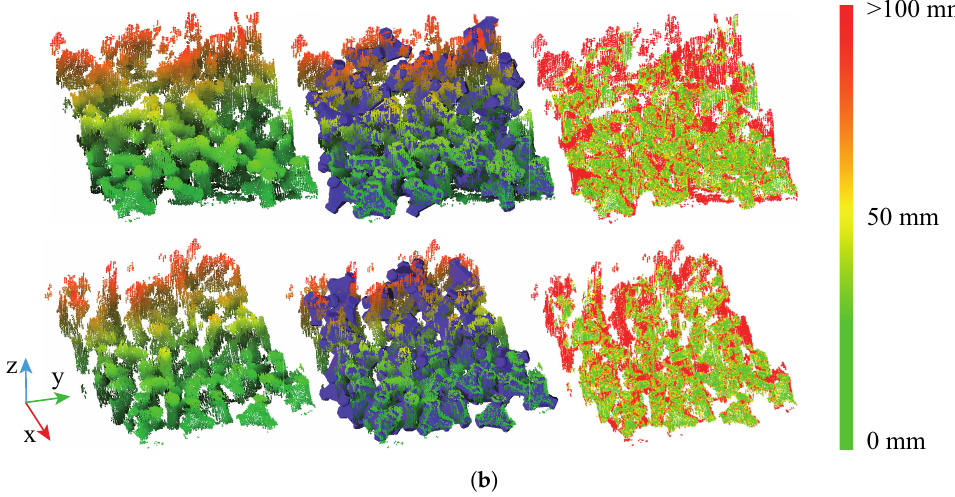
Figure 16. Visualization of pose estimation on UAV data ( a ) and MBES data ( b ) of Sawara port. The first column is the measured point cloud. The block models are transformed to the scene space using pose results and displayed in the middle column. The last column is a visualization of the average fitting error of the pose estimates, where the red points indicate that its distance from the nearest block model is larger than 100 mm. Table 5. Accuracy of pose estimation for various blocks in real scenes. E f : fitting error